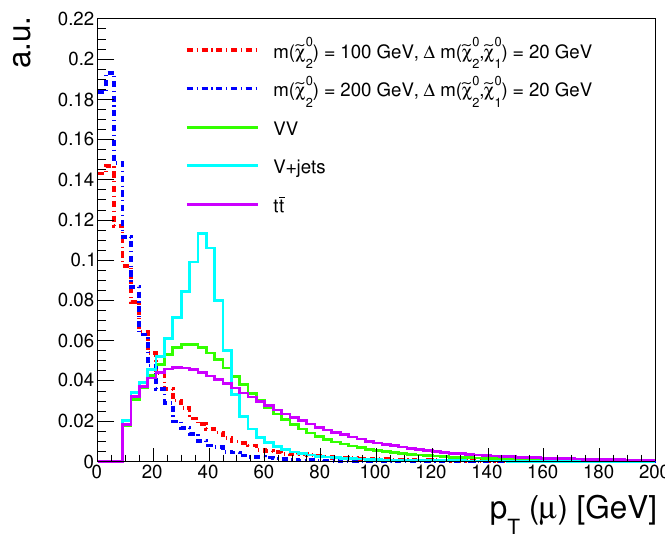
Figure 7 . p T distribution for muons with p T > 3 GeV and | η | < 2 . 5 , for two benchmark signal points and major backgrounds.